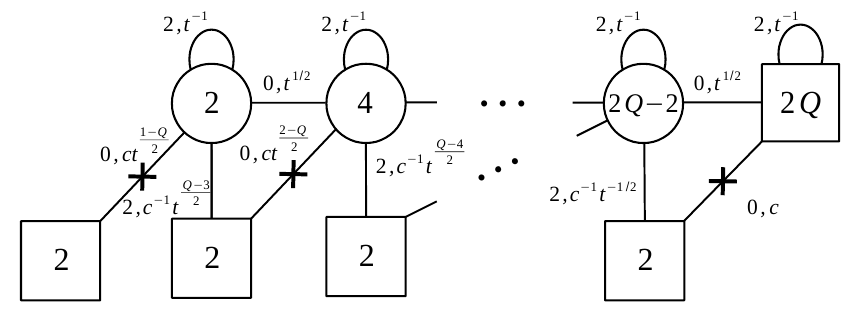
Figure 5: The U ( 1 ) charges of the chiral fields of the F E [ USp ( 2 Q )] theory. Each number before the comma denotes the trial R-charges, while the exponents of c and t represent the charges under U ( 1 ) and U ( 1 ) c t